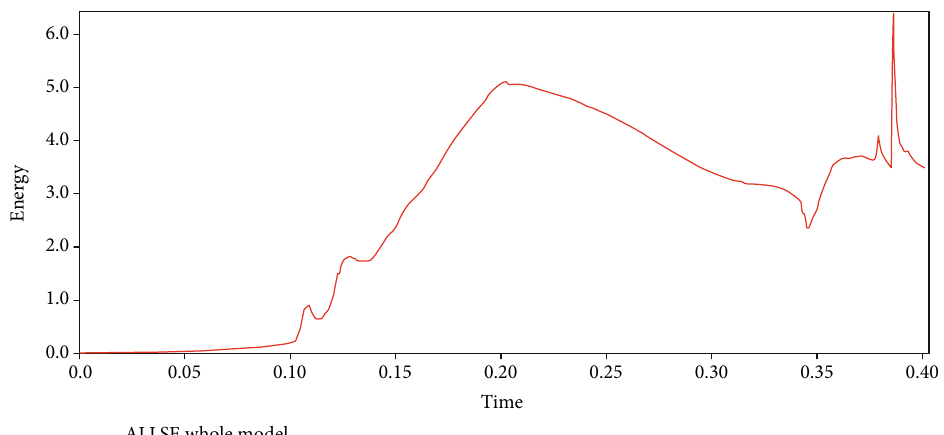
Figure 18: Time history of elastic potential